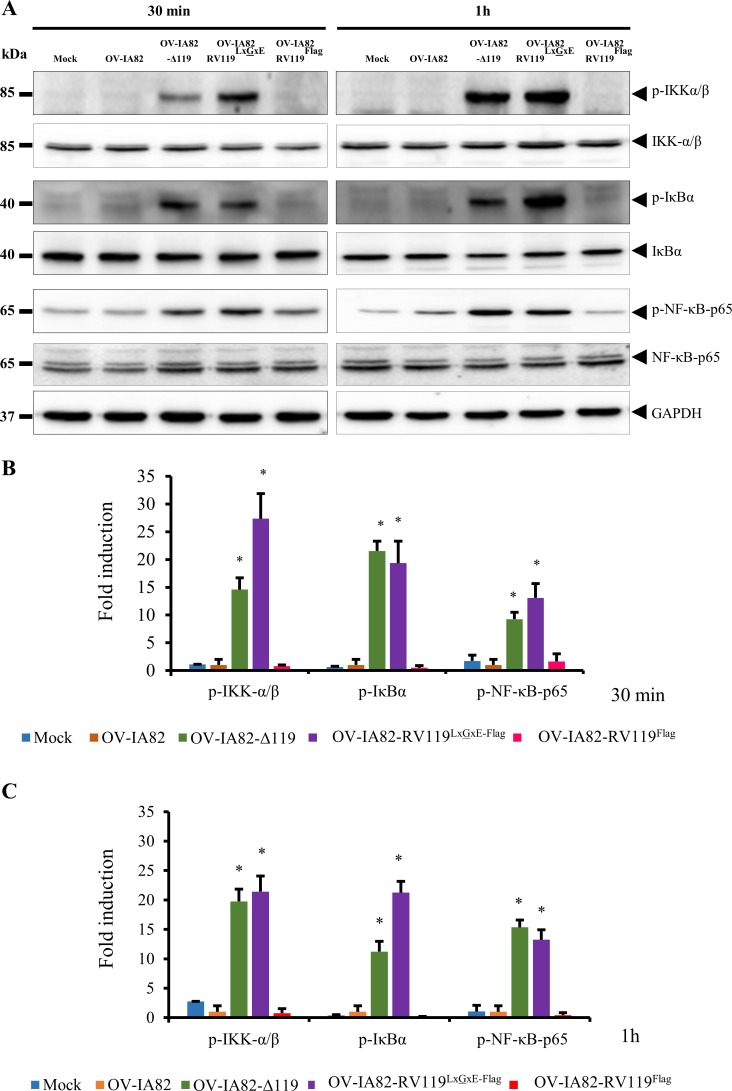
Effect of ORFV119 on IKKα/β, IκBα and NF-κB-p65 phosphorylation.(A) OFTu cells were mock infected or infected with OV-IA82, OV-IA82-Δ119, OV-IA82-RV119LxGxE-Flag or OV-IA82-RV119Flag viruses (MOI, 10) and harvested at the indicated times p.i. Total cell protein extracts (50 μg) were resolved by SDS-PAGE, blotted, and probed with specific antibodies shown on the right. Results are representative of three independent experiments. (B and C) Densitometric analysis of bands corresponding to phosphorylated IKKα/β, IκBα and NF-κB-p65 at 30 min (B) and 1 h p.i. (C). Densitometry of p-IKKα/β, p-IκBα and p-NF-κB-p65 bands were normalized to the loading control GAPDH. Fold changes are shown relative to OV-IA82 treatment and results are mean values of three independent experiments. (*P < 0.05) (OV-IA82 vs OV-IA82-Δ119 and OV-IA82 vs OV-IA82-RV119LxGxE-Flag).